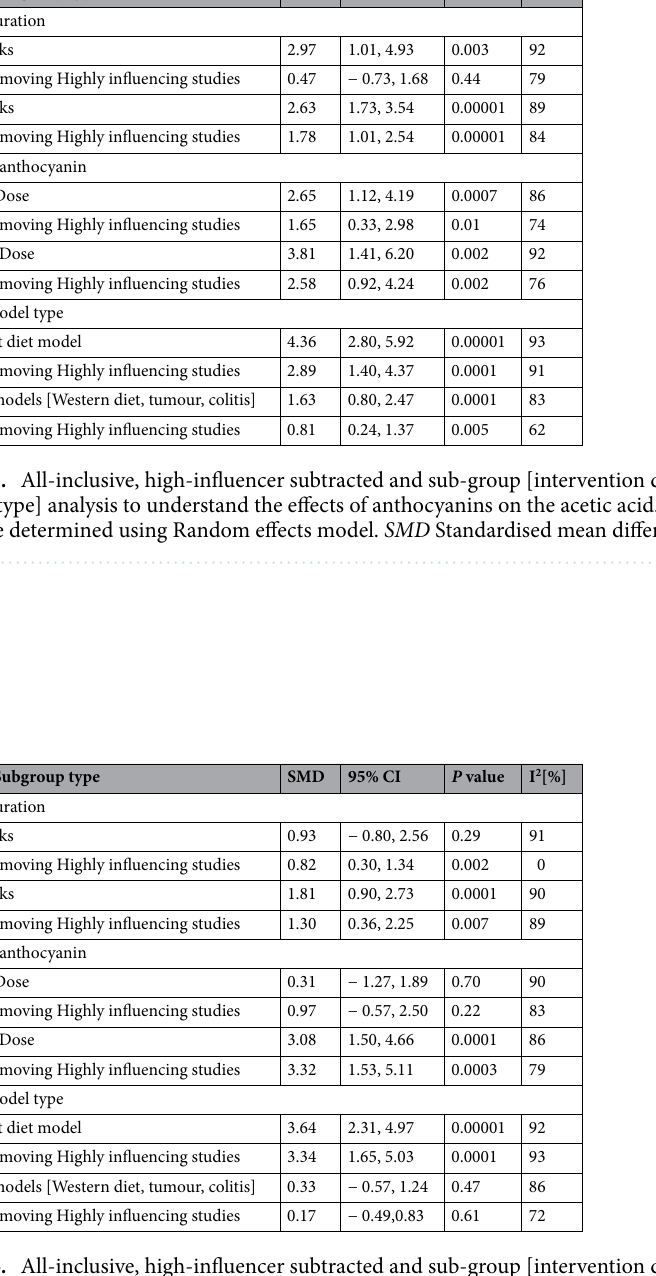
Table 6. All-inclusive, high-influencer subtracted and sub-group [intervention duration, dose, and animal model type] analysis to understand the effects of anthocyanins on the Butanoic acid. Pooled effect sizes and 95% CI were determined using Random effects model. SMD Standardised mean difference, I 2